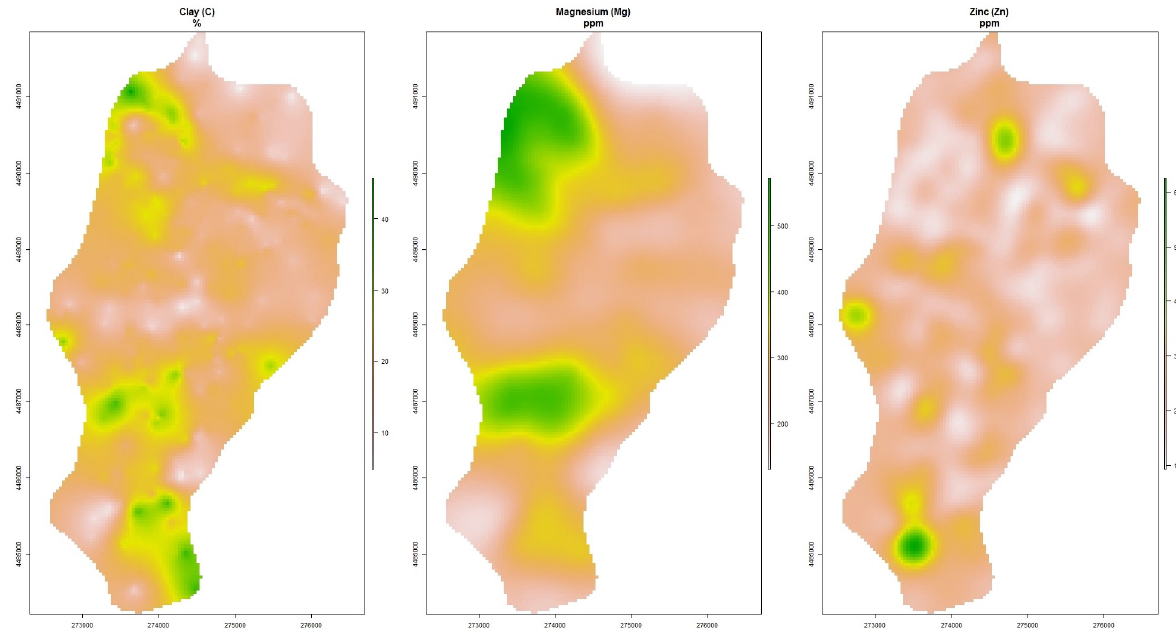
Figure 5. Spatial distribution of soil covariates of the study